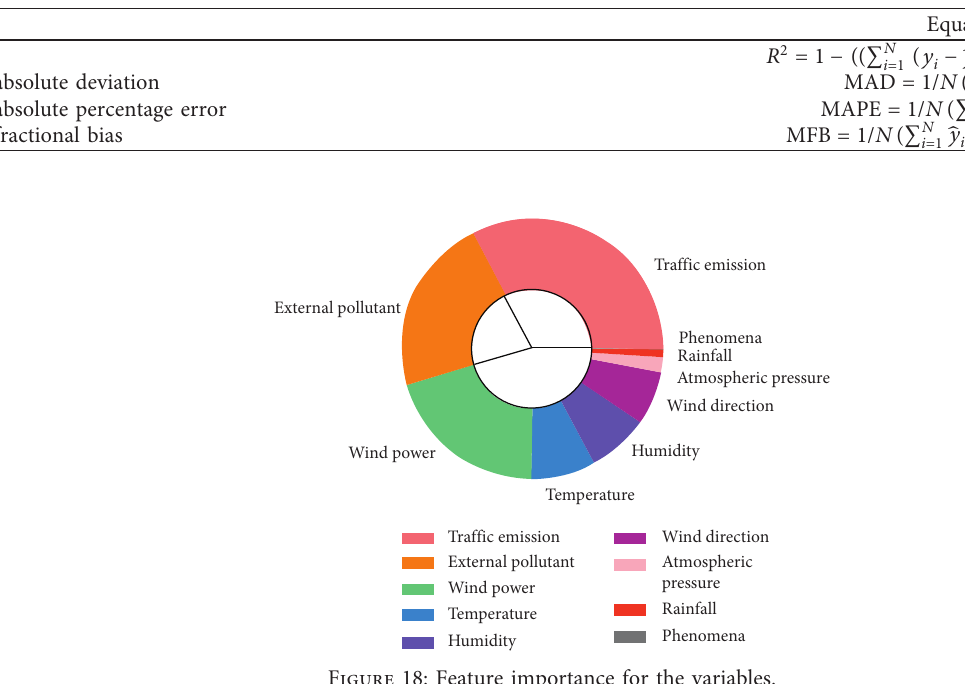
Figure 17: Comparison between experimental monitoring site and model output. Table 7: Goodness of fit.